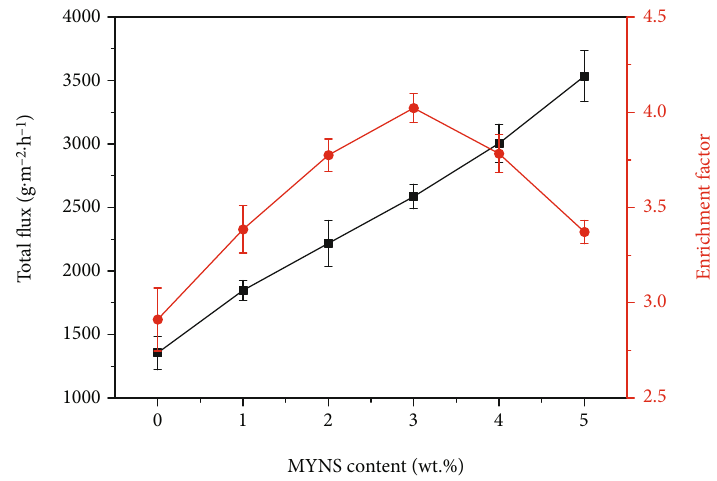
Figure 10: E ff ect of MYNS content on desulfurization performance.